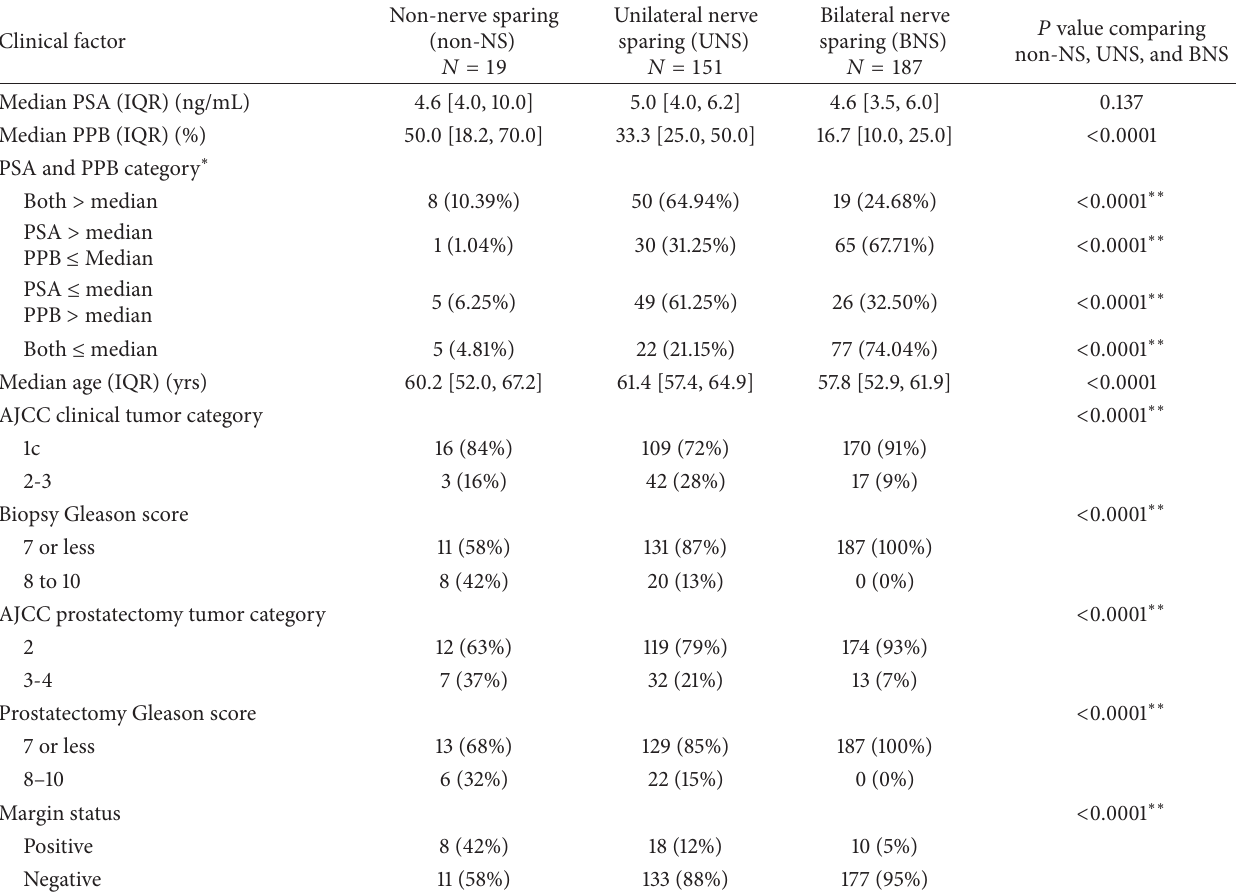
Table 1: Comparison of the distribution of clinical and pathologic factors in men selected for bilateral or unilateral versus non-nerve sparing radical